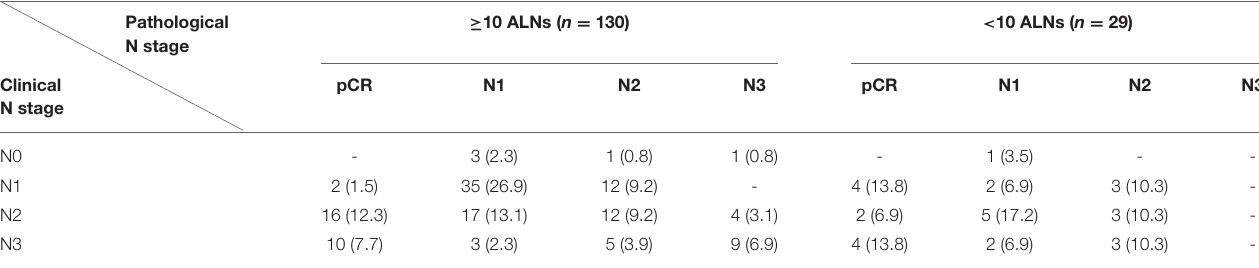
TABLE 4 | Changes of nodal stages in patients with breast cancer who underwent axillary lymph node dissection followed by neoadjuvant chemotherapy. Pathological N